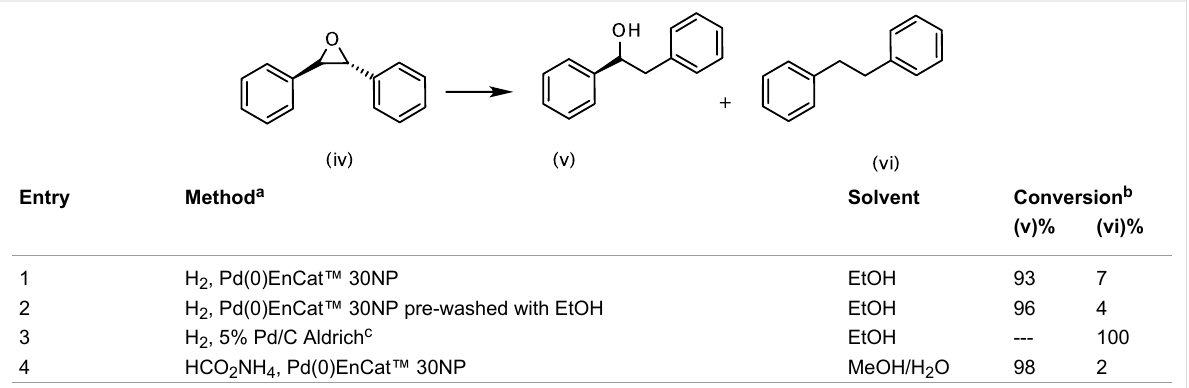
a Reaction conditions: H 2 Balloon or HCO 2 NH 4 , 10 mol% catalyst, r.t., 16 hours. Pd(0)EnCat™ 30NP is supplied as a water wet solid with water content 45% w/w. All NMR data were in agreement with the